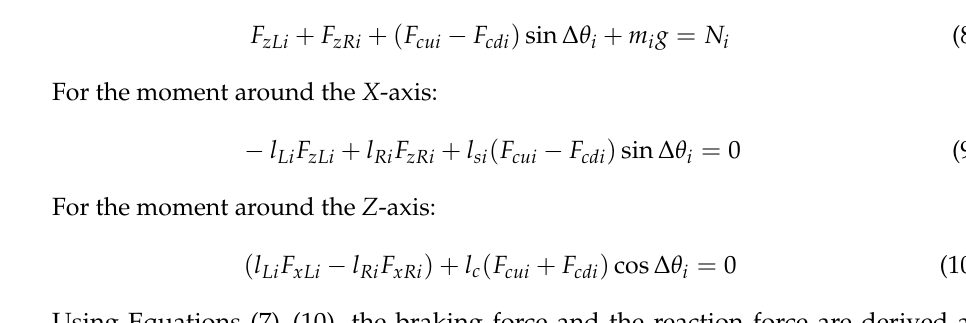
For the moment around the X -axis: